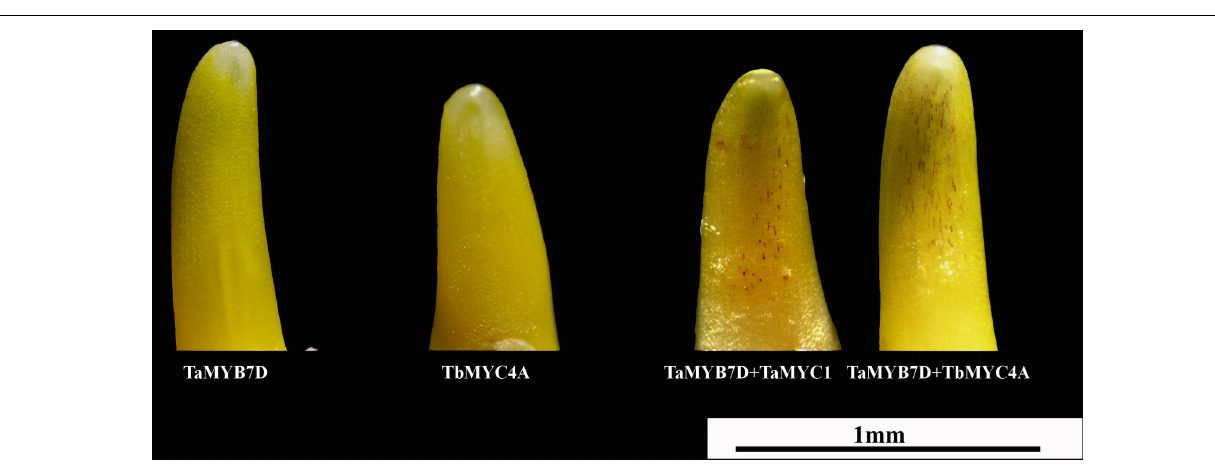
or TbMYC4A and TaMYB7D expression vectors,